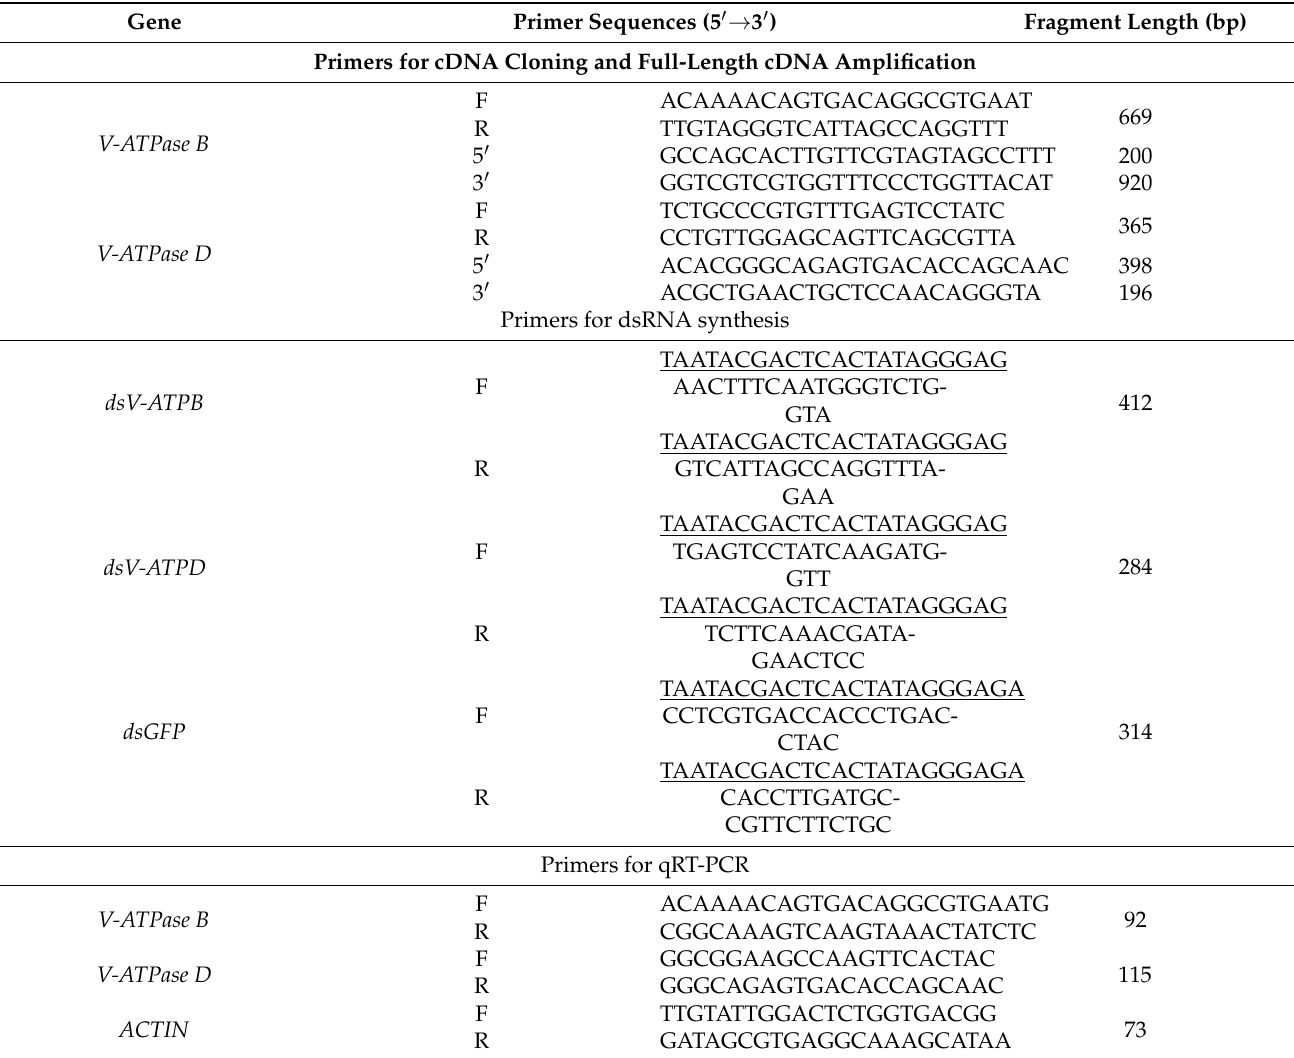
Table 1. Primers used in cDNA cloning, dsRNA synthesis, and real-time quantitative PCR. Gene Primer Sequences (5 (cid:48) → 3 (cid:48) ) Fragment Length (bp) Primers for cDNA Cloning and Full-Length cDNA